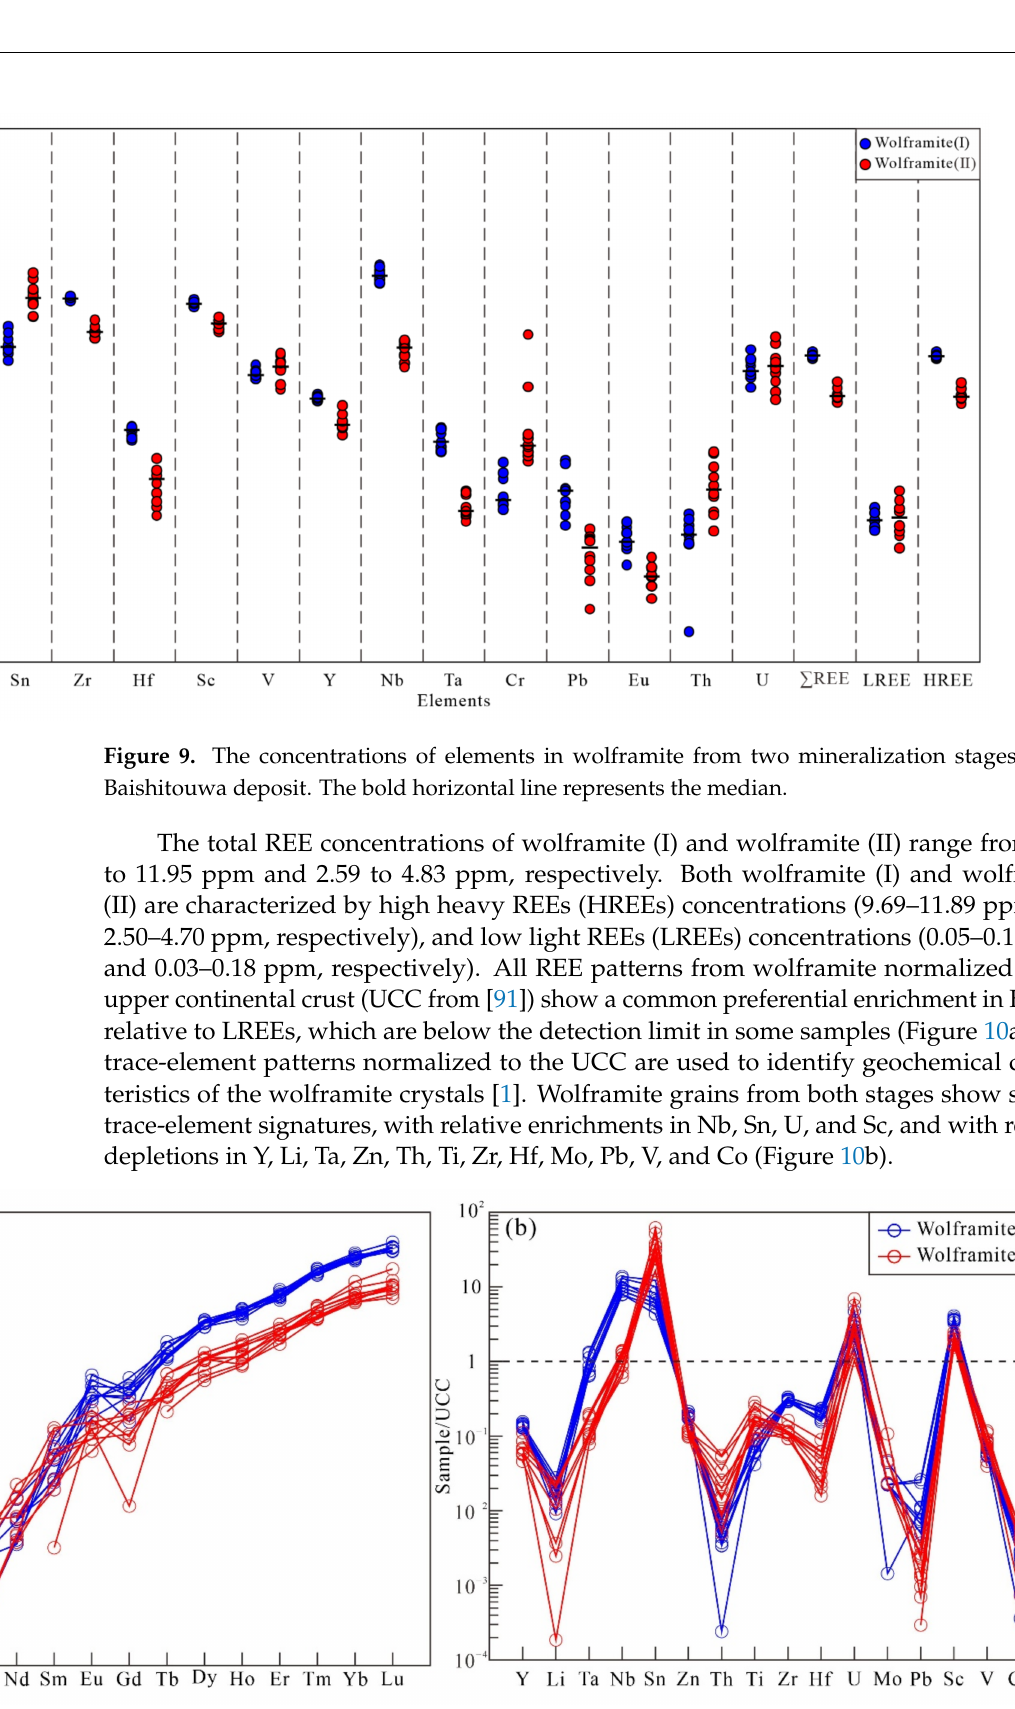
Figure 10. REE ( a ) and trace-element ( b ) patterns of wolframite from the Baishitouwa deposit normalized to the upper continental crust (UCC from